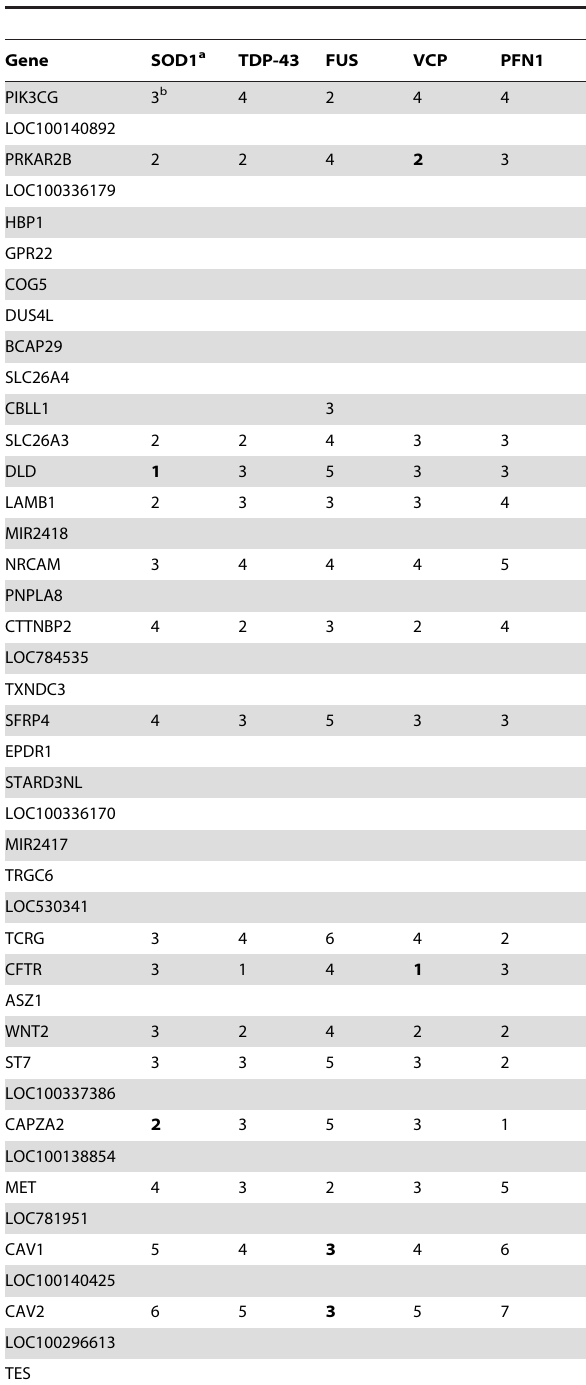
Table 3. Predicted associations between genes in Weaver locus and familial